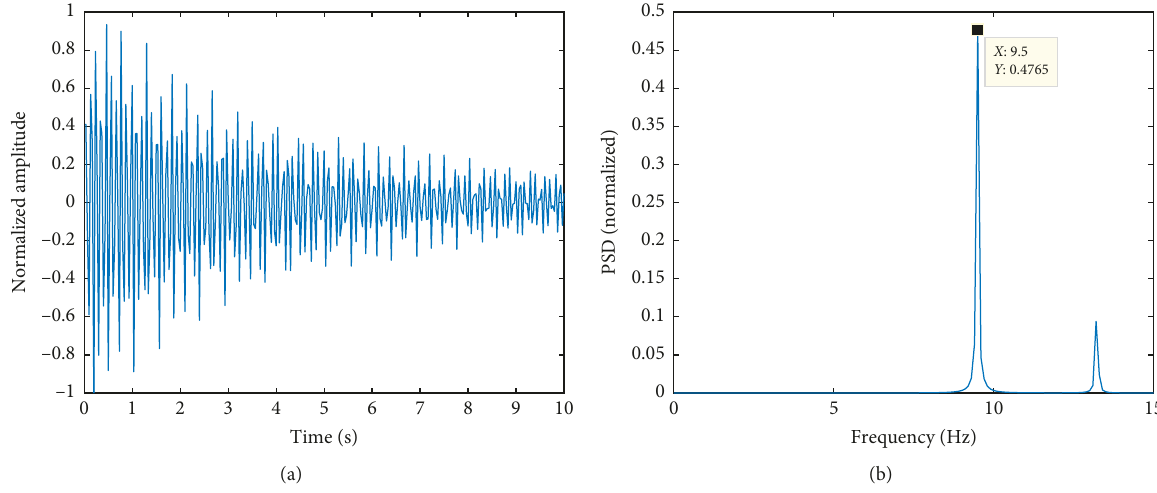
Figure 19: Cantilever steel beam experimental case 1 result from the vibrometer. (a) Normalized acceleration signal. (b) Normalized power spectral